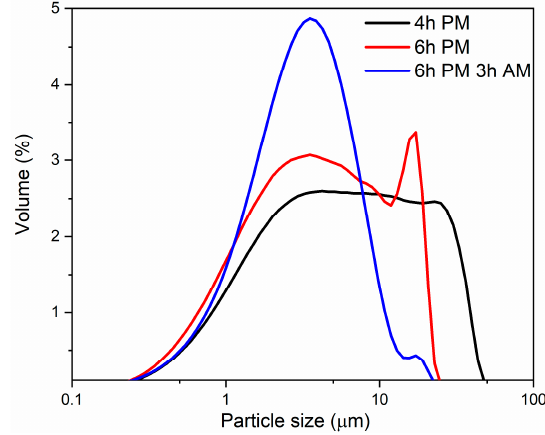
Figure 3. Particle size distributions of glass powders after different time of milling. Black line (4 h PM) corresponds powder milled in planetary mill for 4 h, green line (6 h PM) corresponds to 6 h of planetary milling (PM), blue line (6 h PM, 3 h AM) corresponds to powder obtained after 6 h of planetary milling followed by 3 h of attrition milling (AM). Table 3. Particle size distribution after different times of milling. PM, planetary milling; AM, attrition milling.